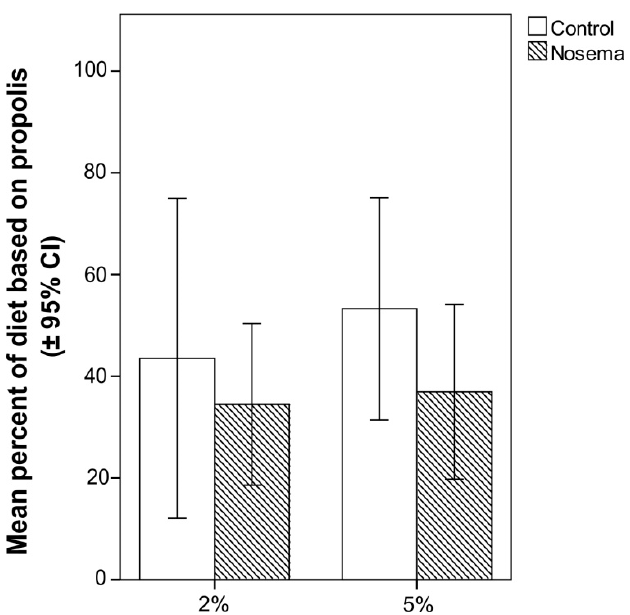
Figure 6. Percentage (± 95% CI) of candy with 2% or 5% propolis in the total diet consumed in Nosema ceranae -infected and control honey bees ( Apis mellifera ); differences between treatments were not significant (GLM, p > 0.05).